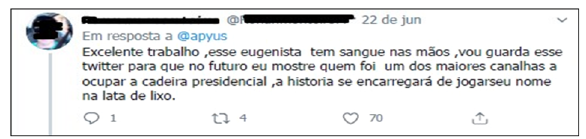
Fig. 9 A re-framer producing a complex reinterpretation of the Covid-19 crisis. Translation : Excellent job, this eugenicist has blood in his hands, I will save this twitter [sic] so that in the future I can show who was one of the biggest bastards to sit on the presidential chair, history will play its part and throw his name into